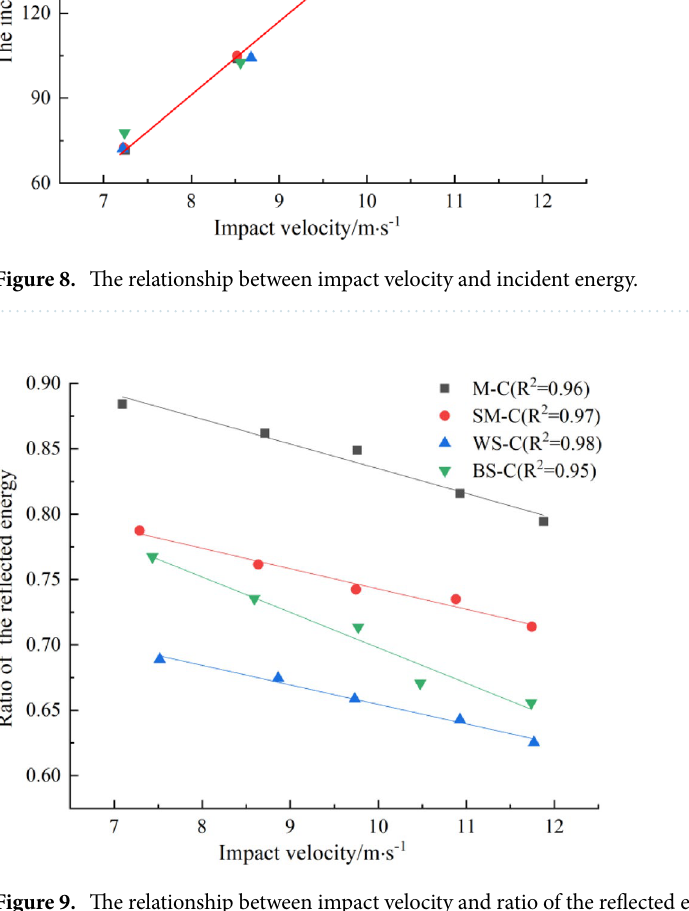
Figure 9. The relationship between impact velocity and ratio of the reflected